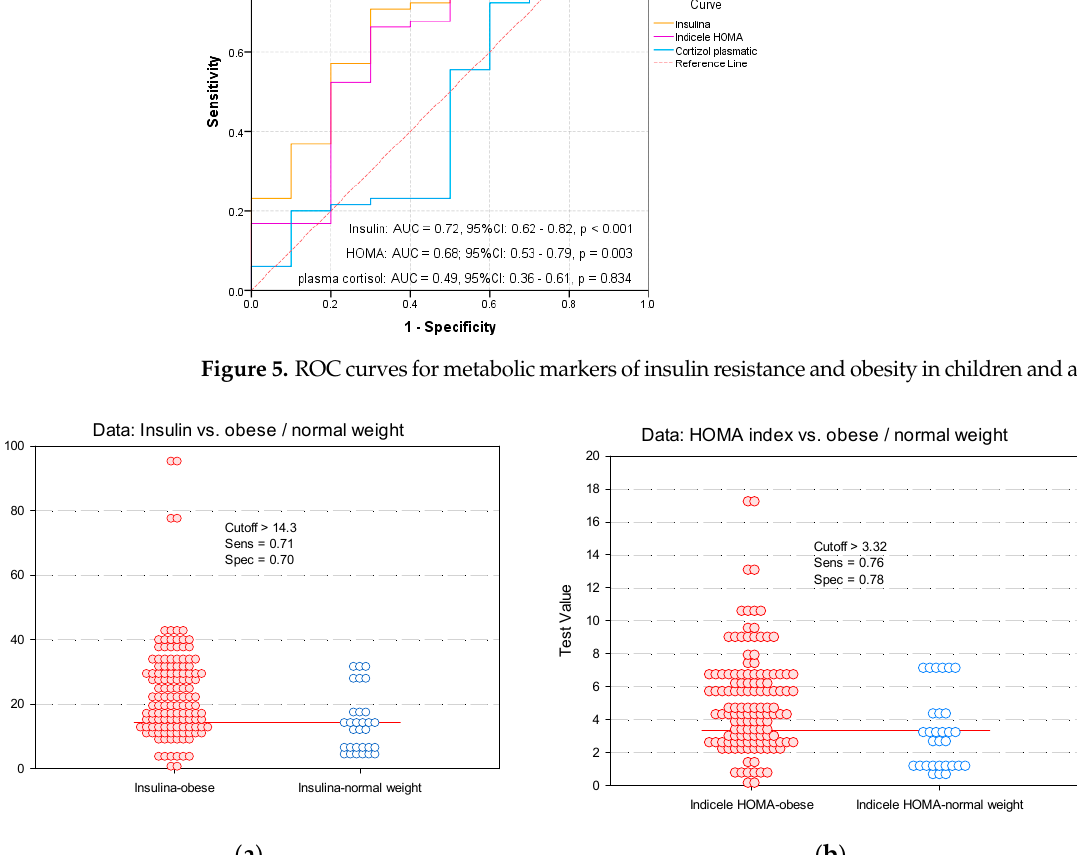
Figure 6. Identifying cut-off values predictive for vascular impairment in obese children and adolescents (dot histogram)